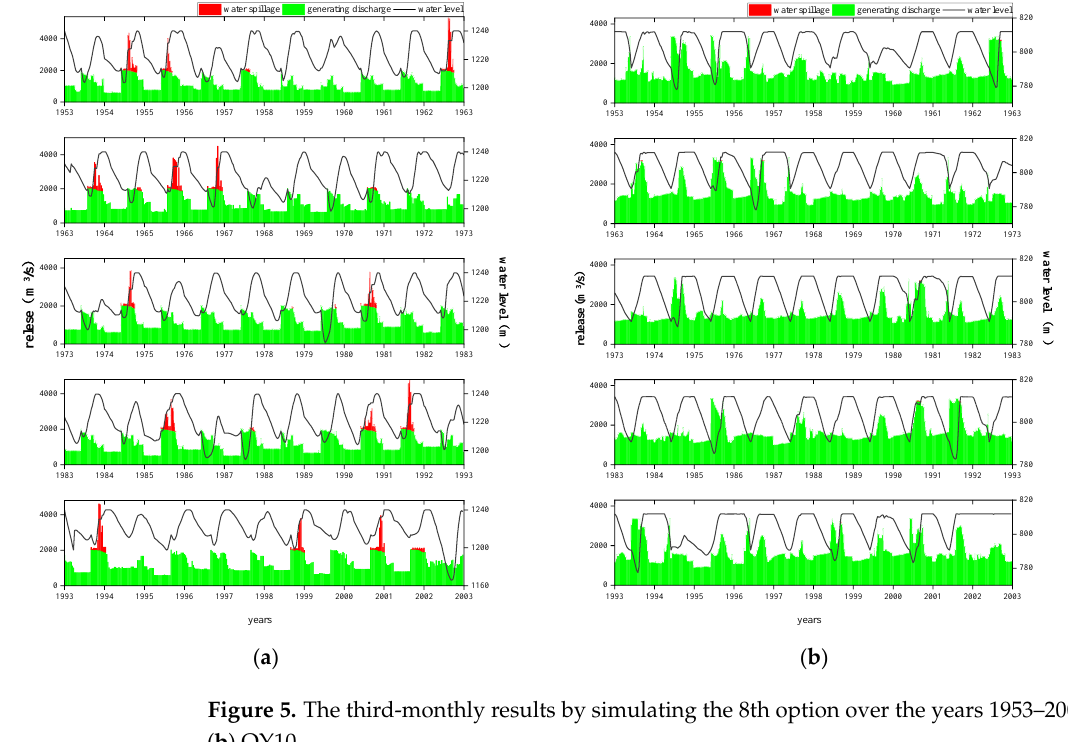
Figure 5. The third-monthly results by simulating the 8th option over the years 1953 – 2002. ( a ) OY07; ( b ) OY10.